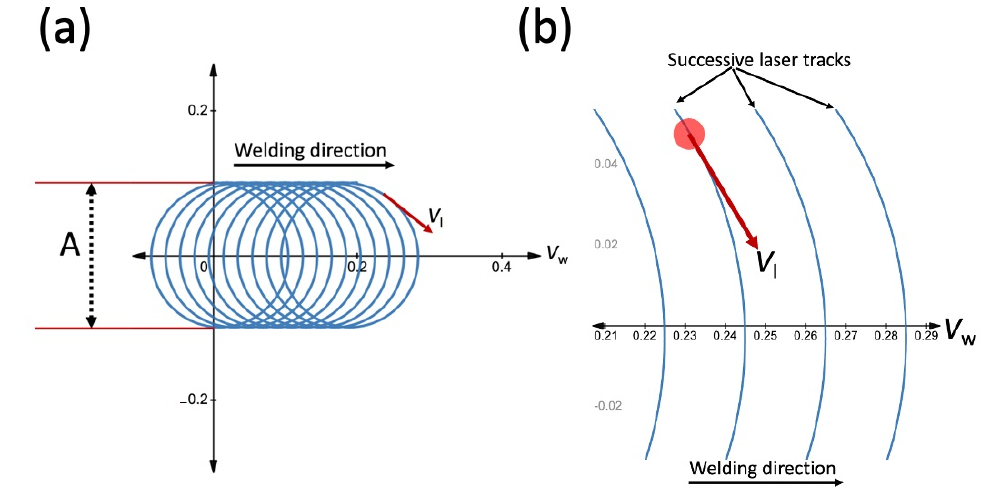
Figure 2. ( a ) Schematic of laser beam oscillation welding ( b ) linear welding speed ( V w ) and laser velocity ( V l ). Table 3. The overlap factor, laser velocity, and interaction time for different oscillation amplitudes and frequencies.